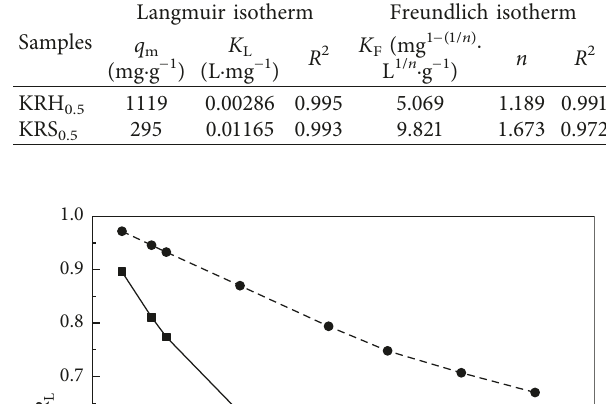
Figure 4: Plot of the separation factor for MG onto KRH KRS 0.5 versus the initial dye concentration.